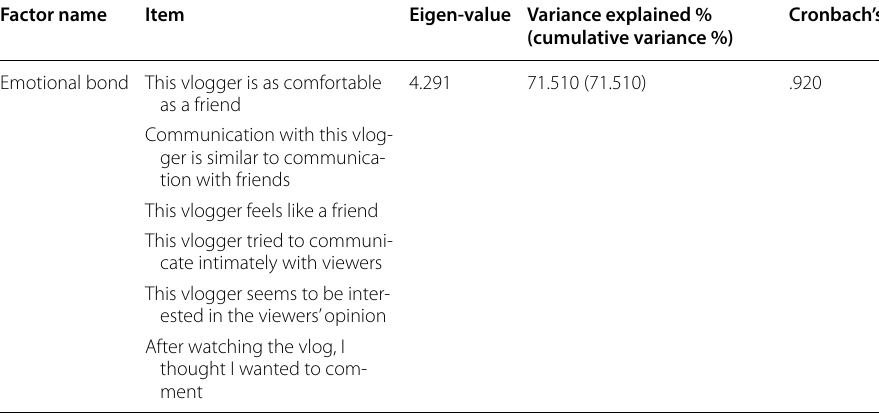
Table 5 The result of principal factor analysis for emotional bond